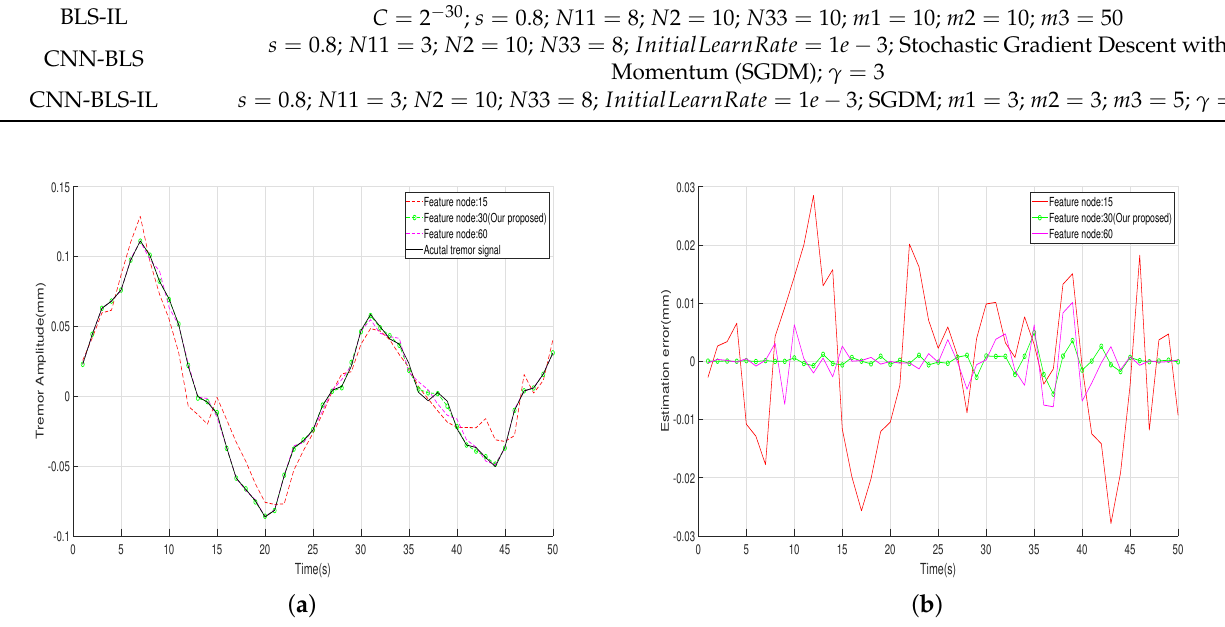
Figure 10. The simulated result metrics of different feature nodes. ( a ) Tremor prediction by different feature nodes in the case of tremors with small amplitude and high − low frequency. ( b ) Estimation error of different feature nodes in the case of tremors with small amplitude and high − low